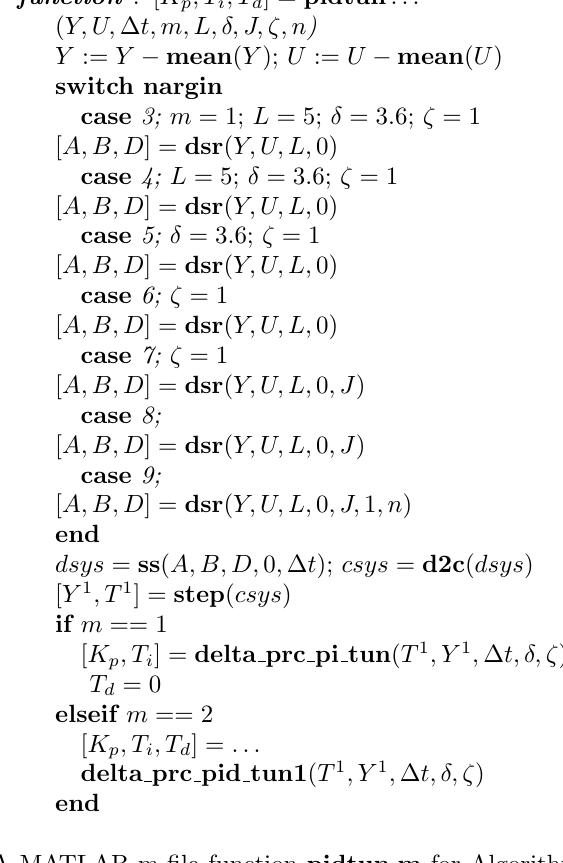
Algorithm 1 Given output and excited input